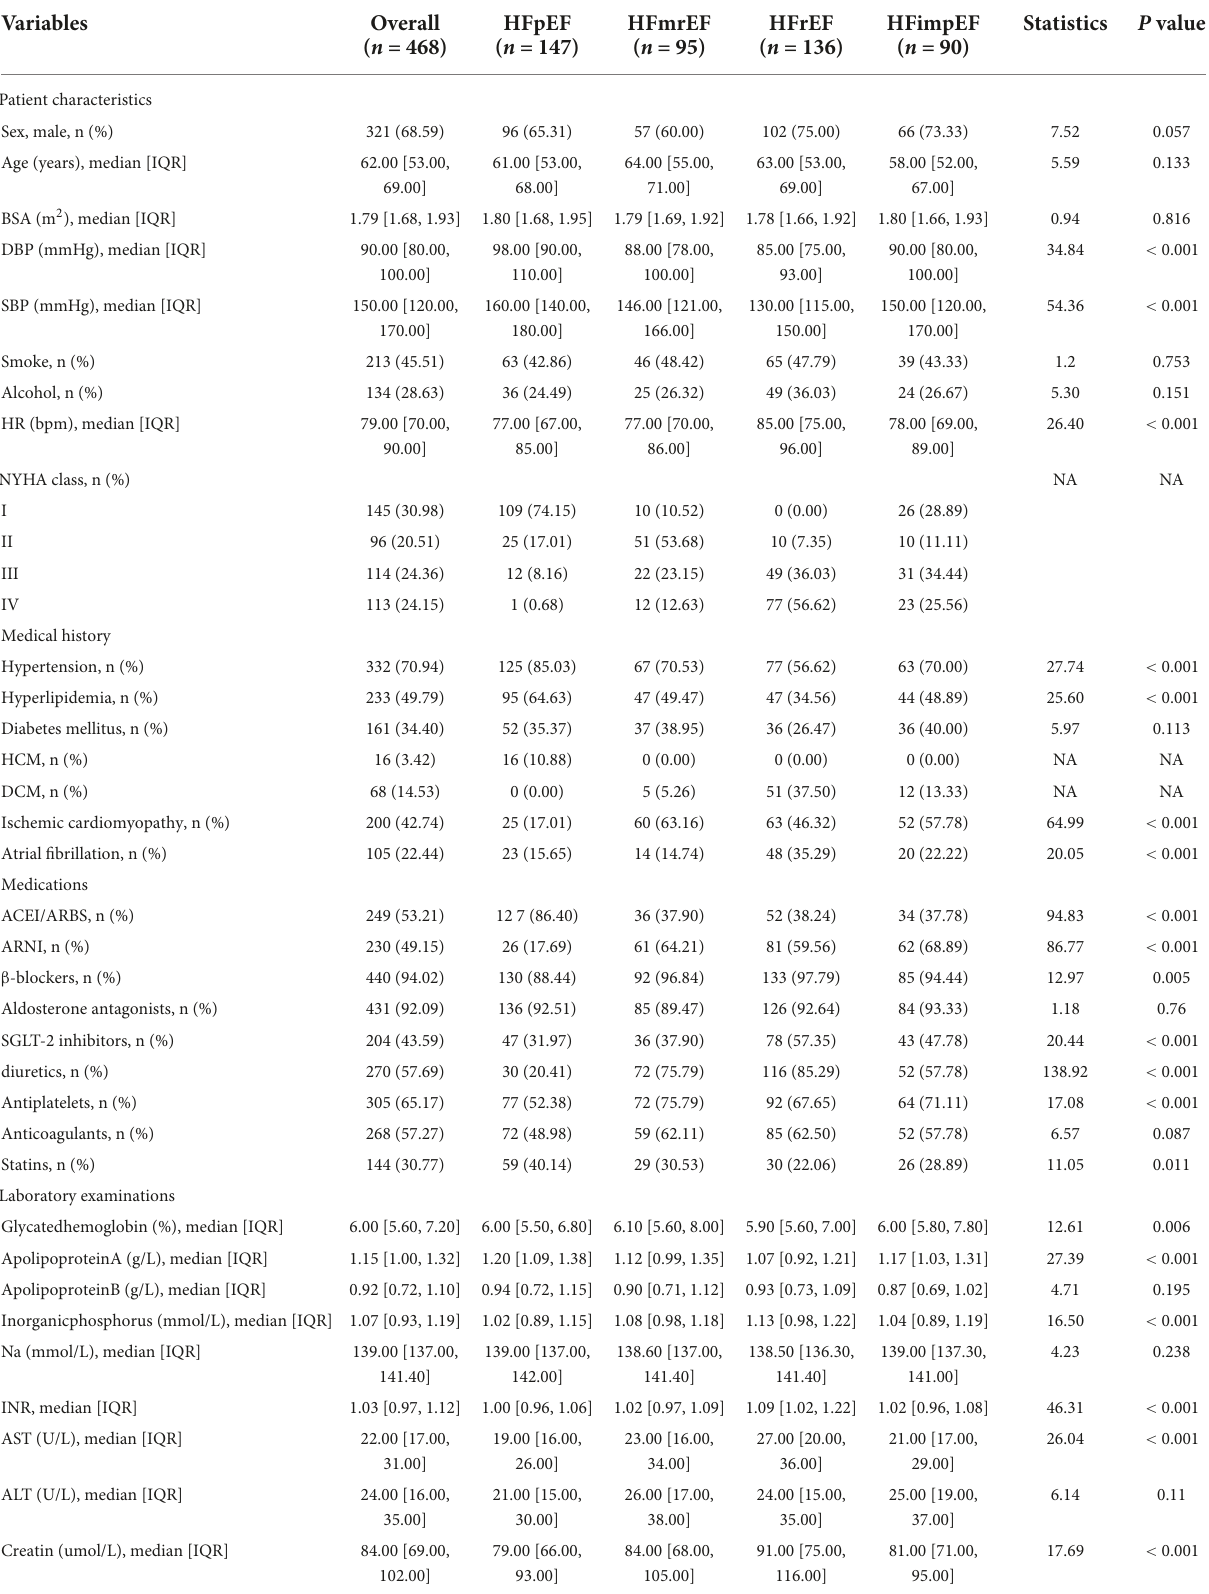
TABLE 2 Baseline characteristics for heart failure (HF) patients divided by left ventricular end fraction (LVEF)